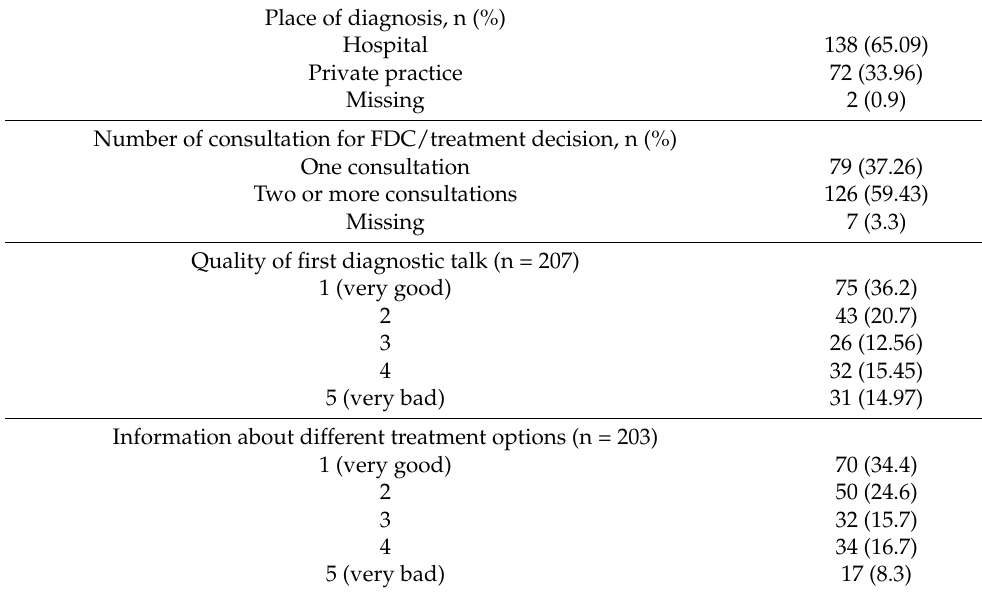
Table 2. Treatment decision (n =